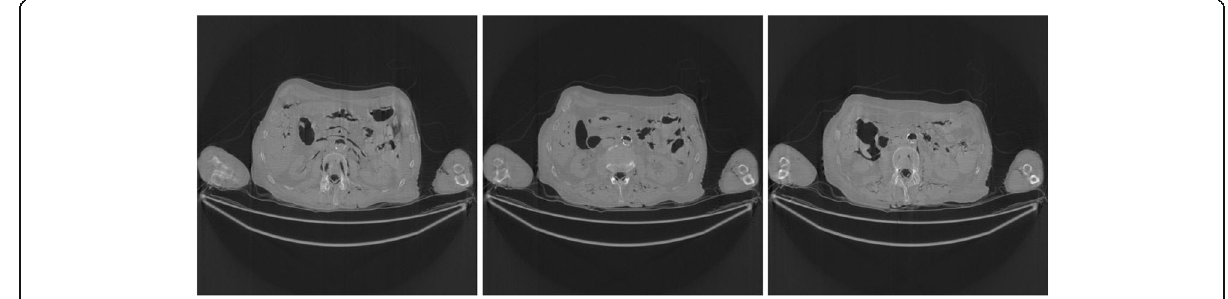
Fig. 1 FBP reconstruction of three image slices using the regular-dose data without pre-filtering. These images are the gold standard images for other images to compare with. Left to Right: Slice 1, Slice 32, and Slice